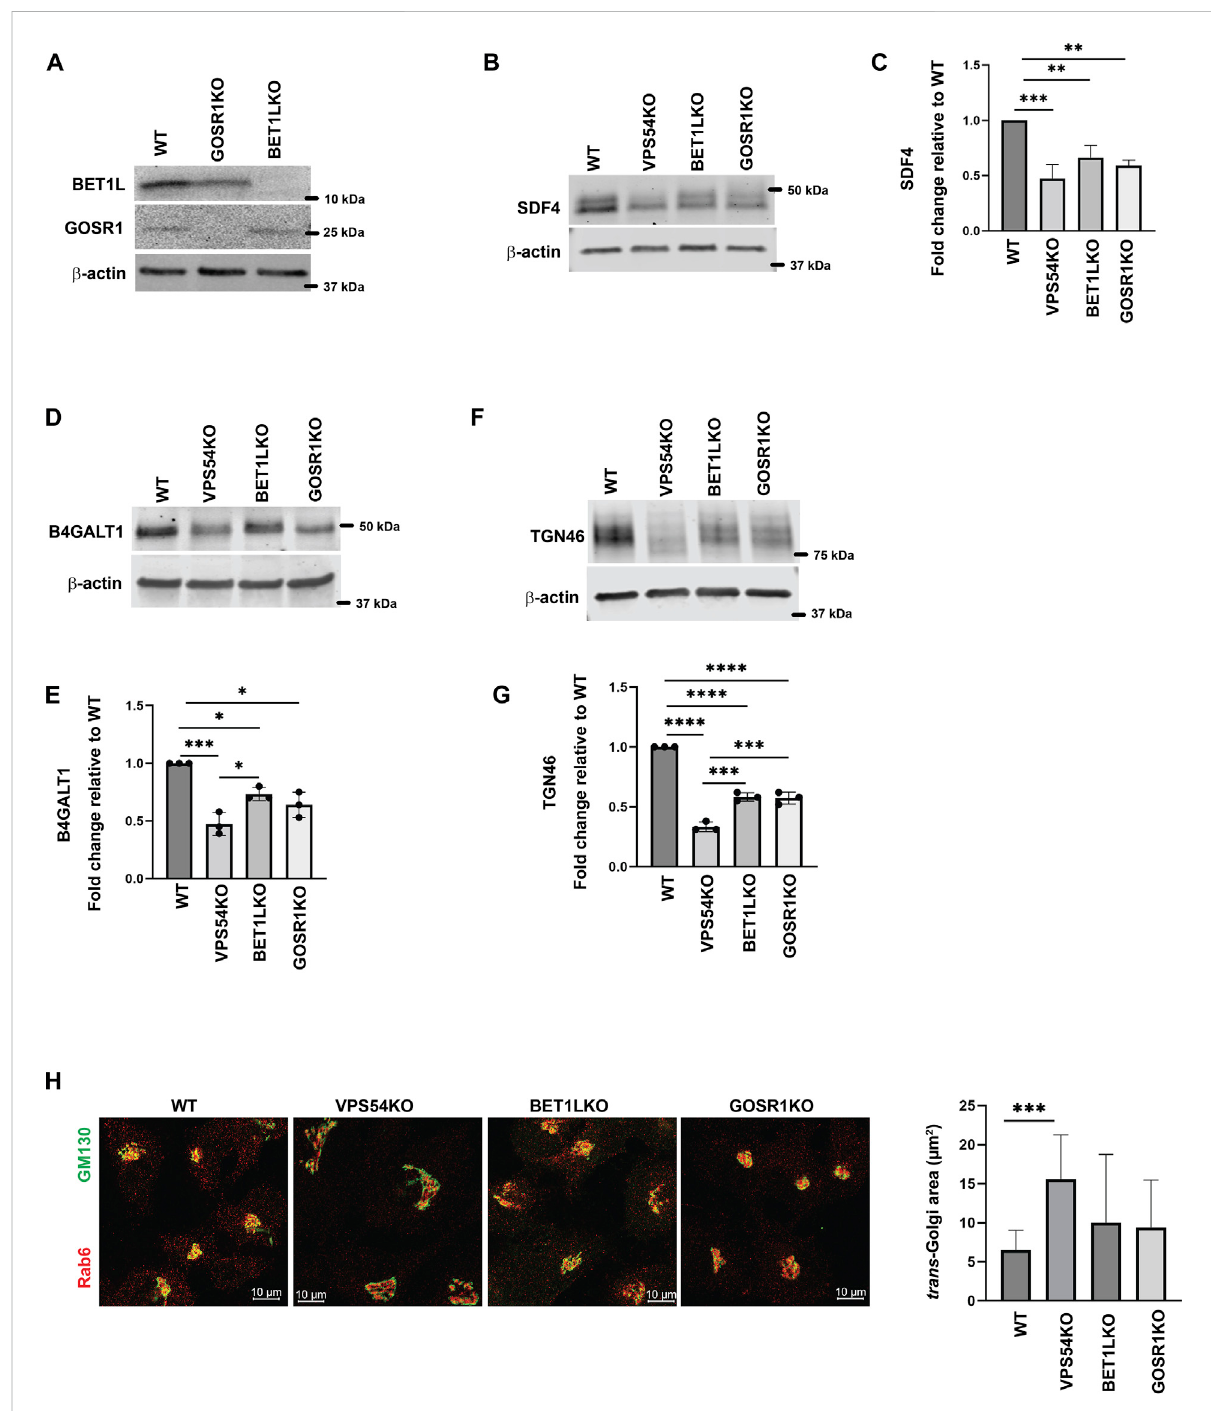
FIGURE 5 GARP-KO is more detrimental to Golgi residents than deletion of Golgi v-SNAREs. (A) Testing of GOSR1KO and BET1LKO by WB analysis. (B) Total cellular lysates were prepared from RPE1 WT, VPS54KO, BET1LKO, and GOSR1KO cells and total protein abundance was analyzed by WB for SDF4, (D) B4GALT1, and (F) TGN46. Normalization was performed using β -actin. Quanti fi cation of relative total protein level of (C) SDF4, (E) B4GALT1, and (G) TGN46. Statistical analysis was done from three independent blots, where **** p ≤ 0.0001, *** p ≤ 0.001, ** p ≤ 0.01, * p